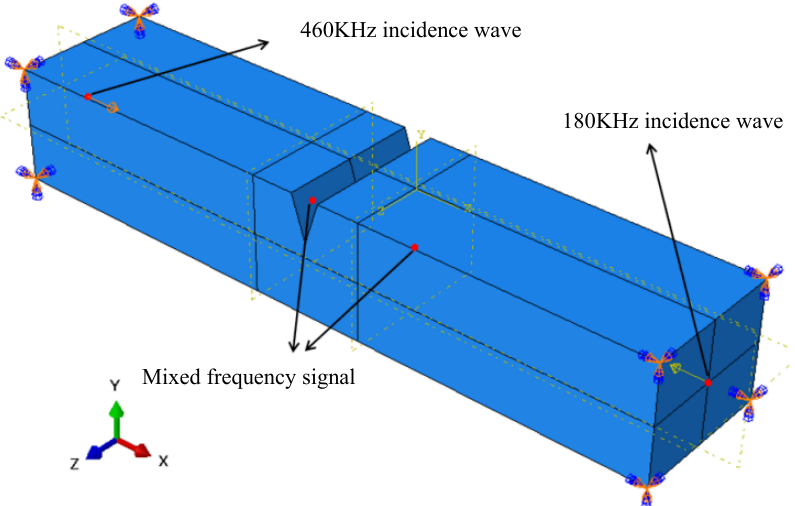
Figure 11. Excited incidence waves and received signal in the FEA model.